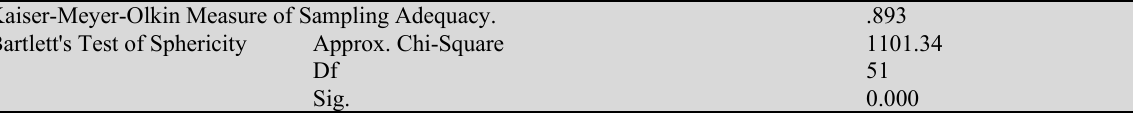
KMO and Bartlett's Test of Research Variables Kaiser-Meyer-Olkin Measure of Sampling